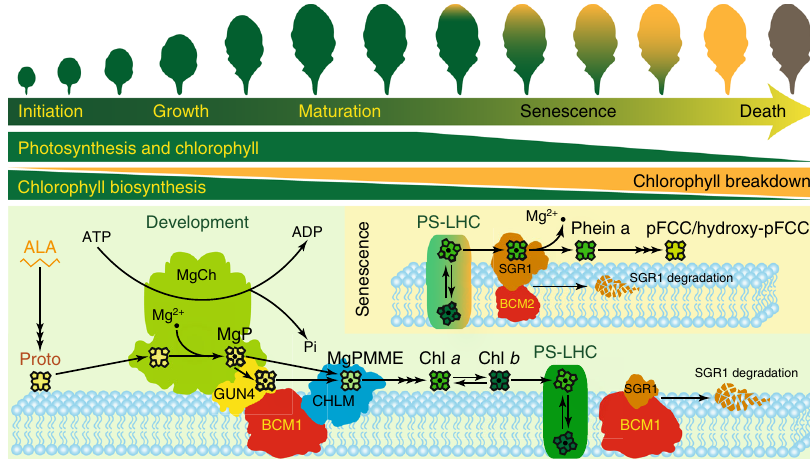
Fig. 8 Model for the concurrent regulation of Chl biosynthesis and catabolism by BCMs. During early leaf development (encompassing leaf initiation, growth, and maturation), optimized Chl biosynthesis ensures ef fi cient photosynthesis, while Chl breakdown is largely suppressed. BCM1 promotes Chl biosynthesis by stimulating MgCh through GUN4 action, and in addition interacts with and destabilizes SGR1 to prevent Chl degradation. Upon the onset of leaf senescence, although BCM1 is greatly suppressed, BCM2 and SGR1 are both up-regulated. BCM2 is therefore able to contribute to the inhibition of Chl breakdown. However, the strong accumulation of SGR1 eventually allows plants to initiate Chl